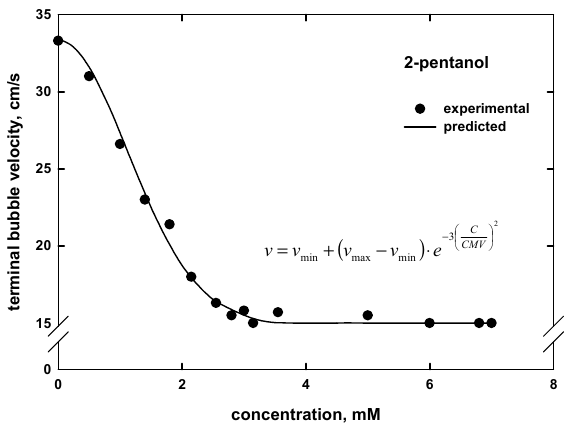
Figure 11. Comparison of measured [2] and predicted (Equation (1)) values of terminal bubble velocity v vs. 2-pentanol concentration.